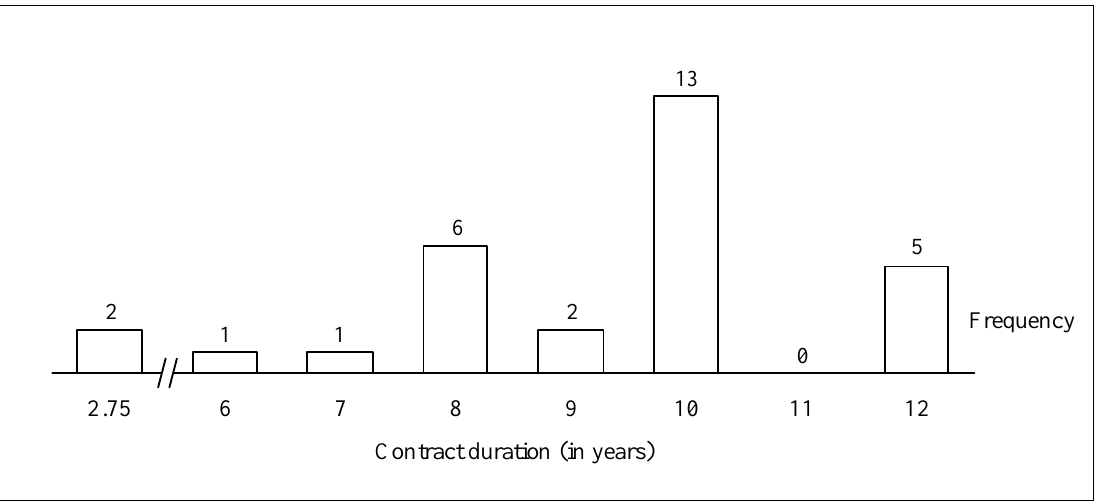
Figure 3. Frequency distribution of regular contract